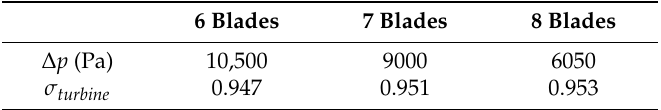
Table 3. Pressure difference, ∆ p , between pressure and suction side of the blades for the three geometries with different number of blades and n q equal to 20.